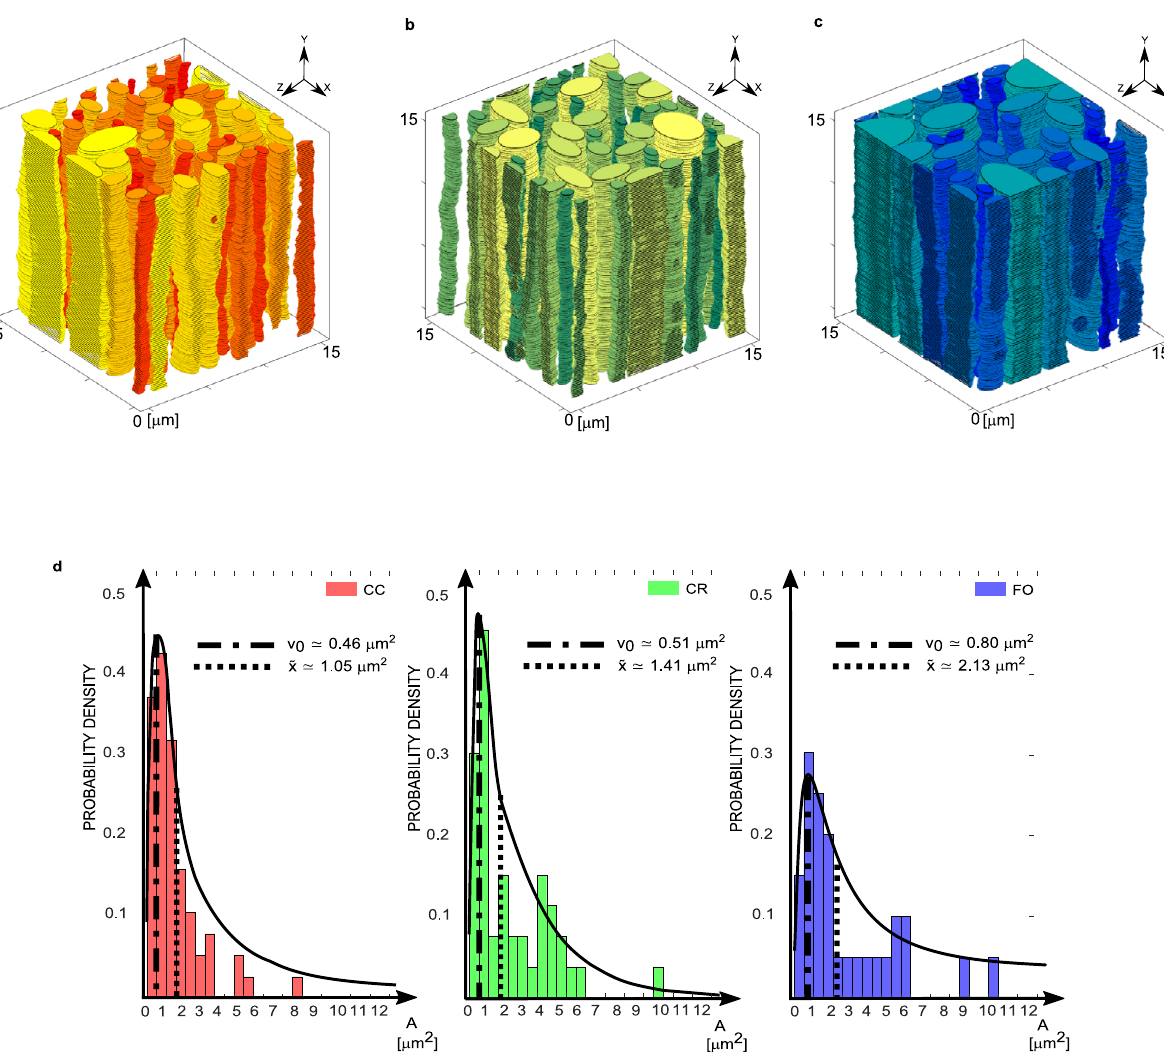
Fig. 8 3D Representative Volume Elements of WM tracts generated in silico. a – c Three volumes of 15 × 15 × 15 μ m 3 were virtually reconstructed for CC (in red), CR (in green) and FO (in blue). These “ in vitro ” WM volumes are representative of the three different zones in terms of cross-sectional area, cross-sectional diameter, tortuosity, axonal density and volume fraction. The input data (a dataset per each WM tract) for the code consists in: the parameters ( μ , σ ) of the data distribution of the area, the minimum and maximum ellipticity value, the average axonal density, the average volume fraction and its standard deviation, the interlayer variability of the measured area, the average interlayer tortuosity and its standard deviation and the interlayer difference in semi-axis length. This overall dataset has been extrapolated from the experimental dataset as all the aforementioned quantities are saved per each slice, per each axon, per each volume in each subject. d The underlying probability density distribution obtained for the in silico reconstructed RVEs. The reconstructing algorithm is given some freedom in the creation of the volumes in order to accommodate the axons to follow the distributions of the experimental measurements. The volumes are created in order to be periodic in the x – y direction and therefore are ready to be imported as STL fi les into commercial Finite Element Analysis software (e.g. ABAQUS 110 ). The commented source codes are provided in the Supplementary Information, where more details can be